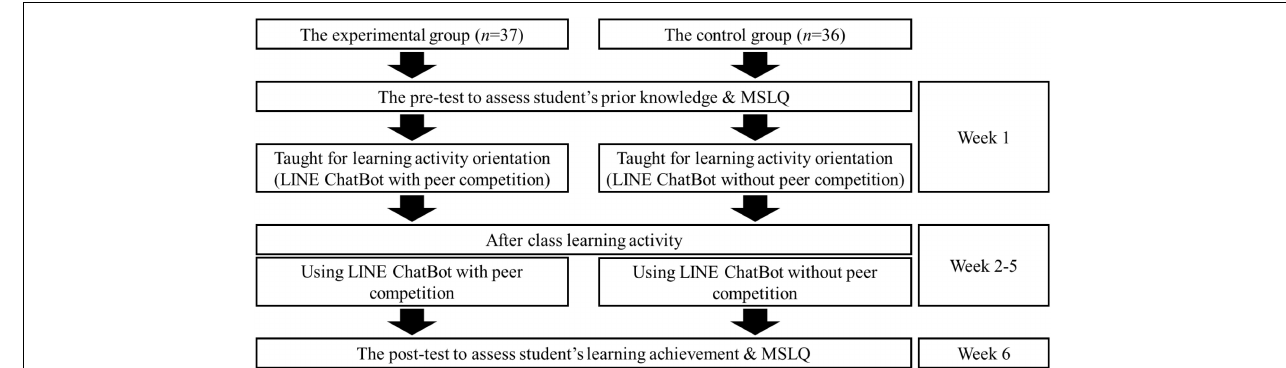
FIGURE 1 | Experimental